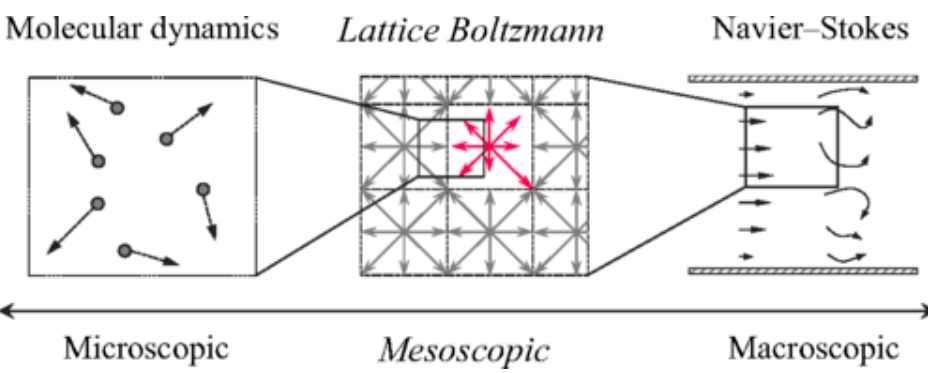
Figure 2. Different levels of numerical methods used in cellular flow manipulation. Adapted from [54].